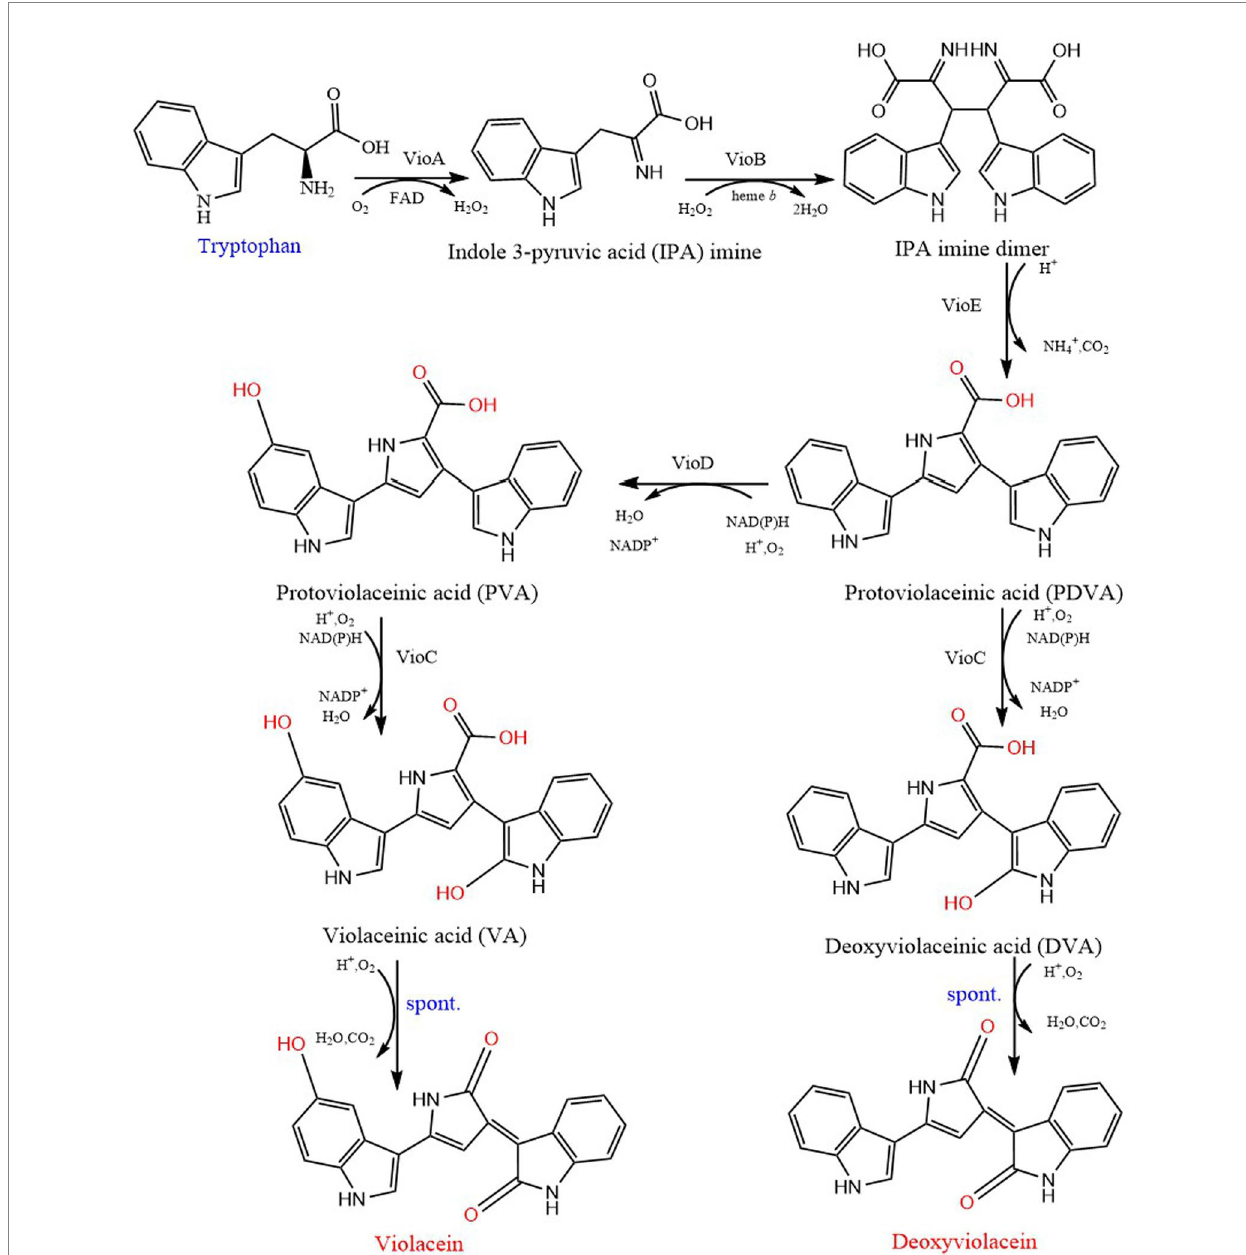
FIGURE 6 Biosynthetic pathway of violacein and deoxyviolacein. VioA, tryptophan oxidase; VioB, iminophenyl-pyruvate dimer synthase; VioE, violacein biosynthesis enzyme; VioD, protodeoxyviolaceinate monooxygenase; VioC, violacein